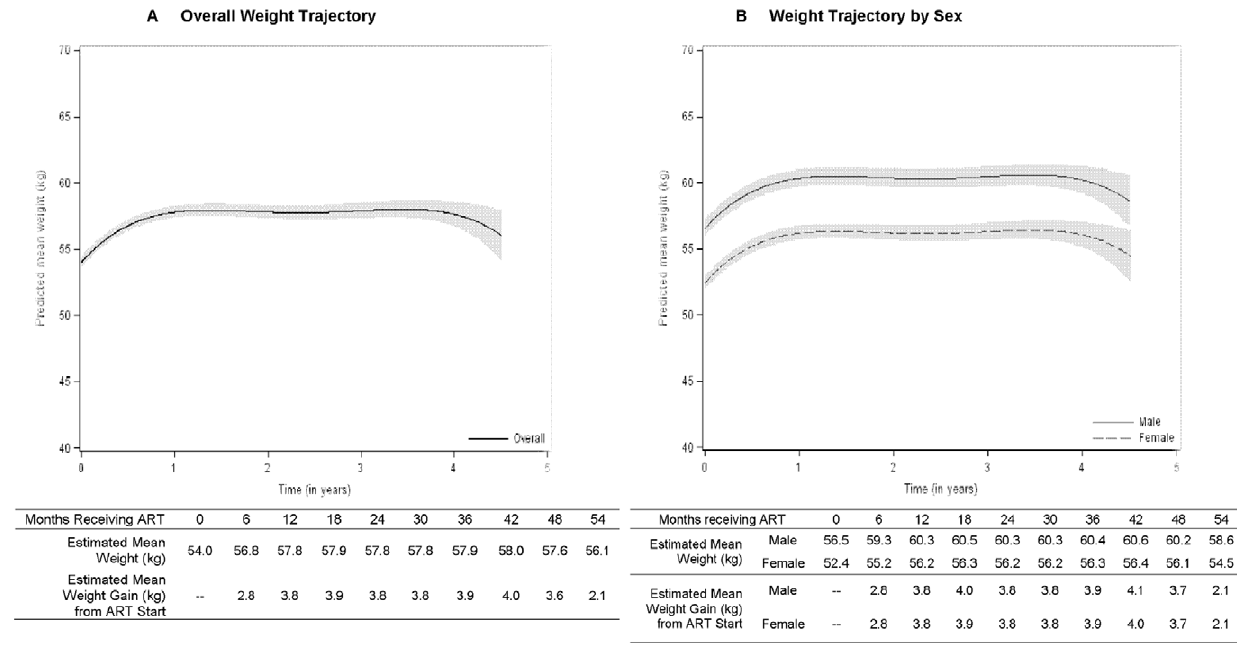
Figure 3. Modeled changes in weight over time for surviving patients initiating ART during 2004–2007.